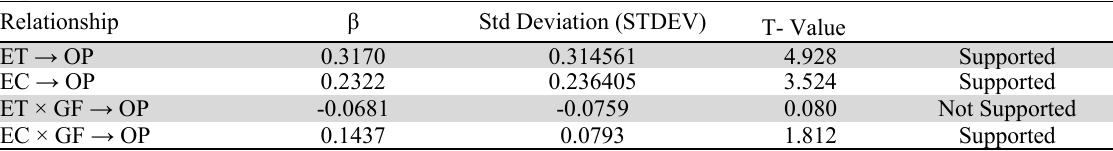
Hypotheses Test